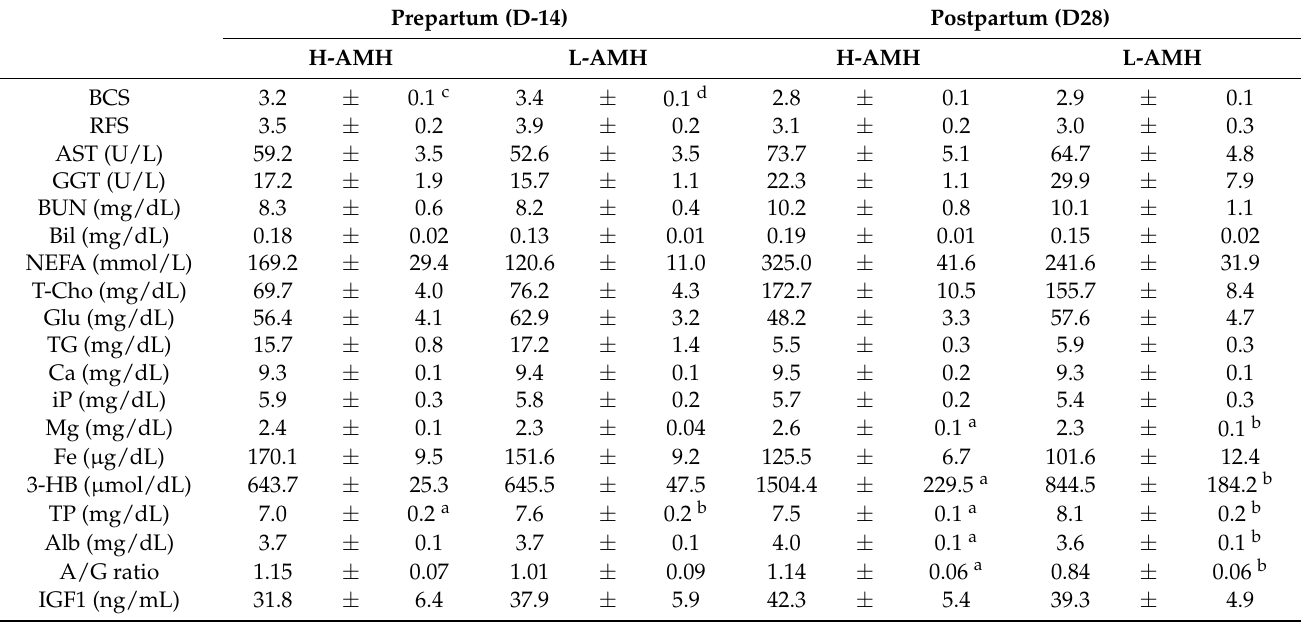
Table 3. Results of body condition score (BCS), rumen fill score (RFS), and serum biochemical analyses (mean ± SEM) of H- and L-AMH cows at pre- (D-14) and postpartum (D28) periods.